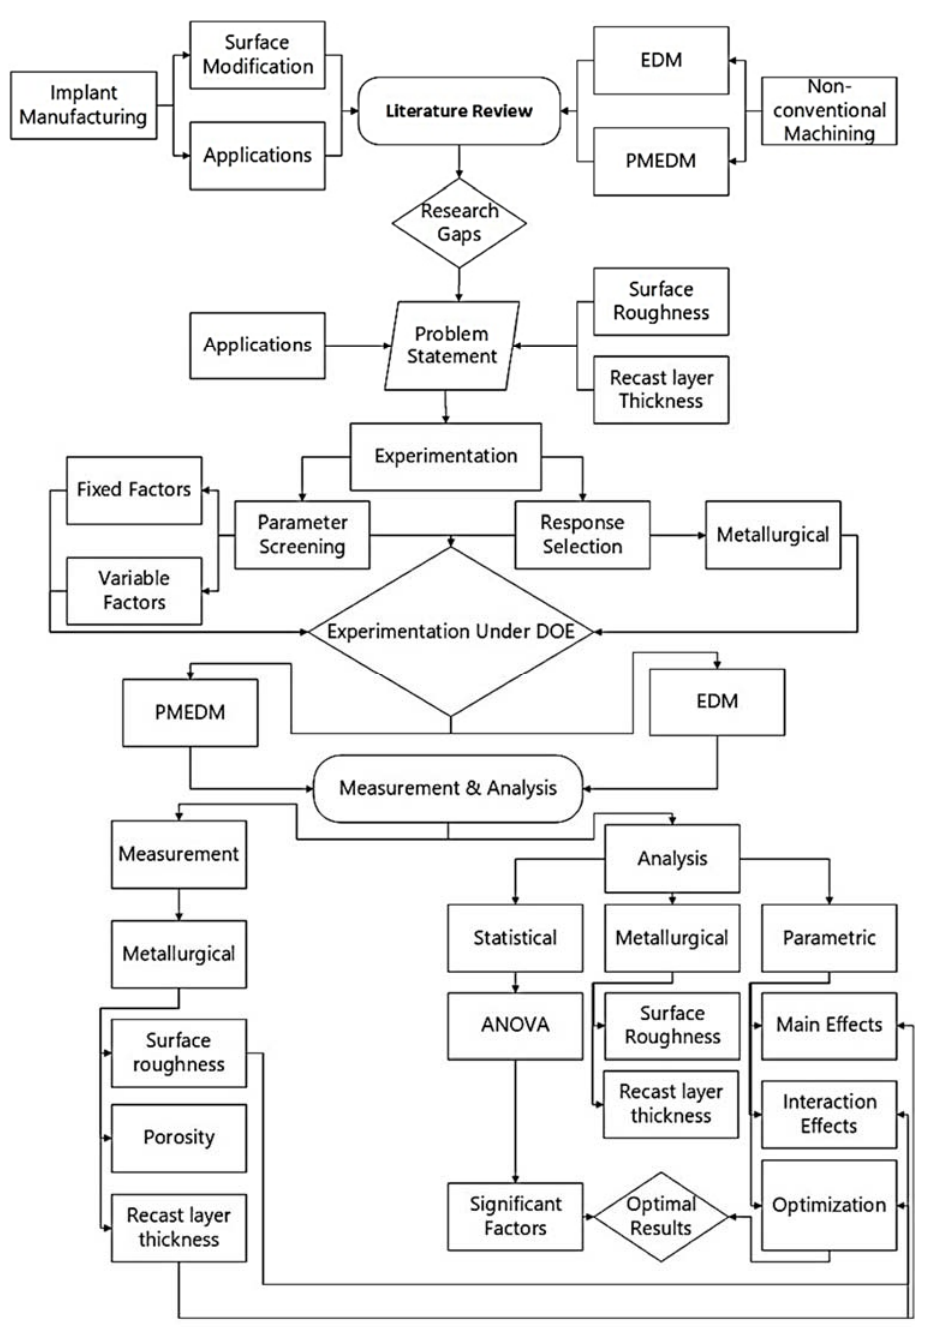
Figure 3. The overall methodology of the research project.